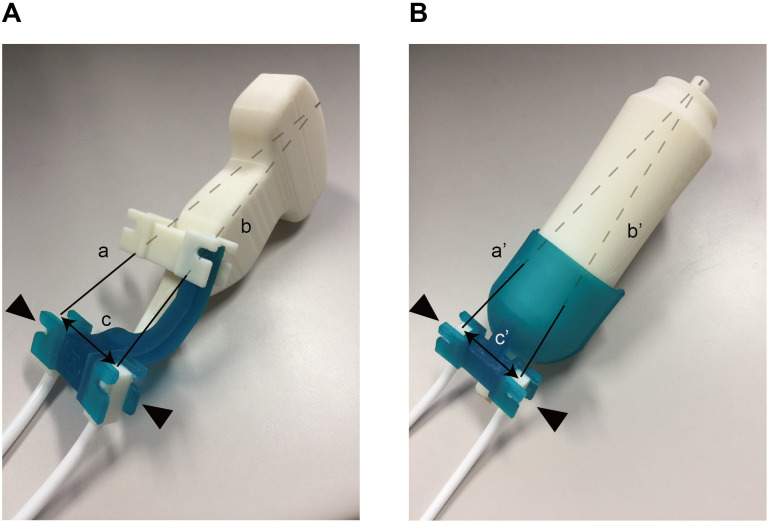
New devices to attach to the ultrasound probes.A) To attach the electromagnetic position sensors (black arrowhead) with the convex probe, we developed a device using the three-dimensional (3D) printer. B) To attach the sensors to the M probe, another new device (black arrowhead) was similarly developed. Each distance was matched between the tip of the probe and the position sensors (a = a’, b = b’, c = c’).